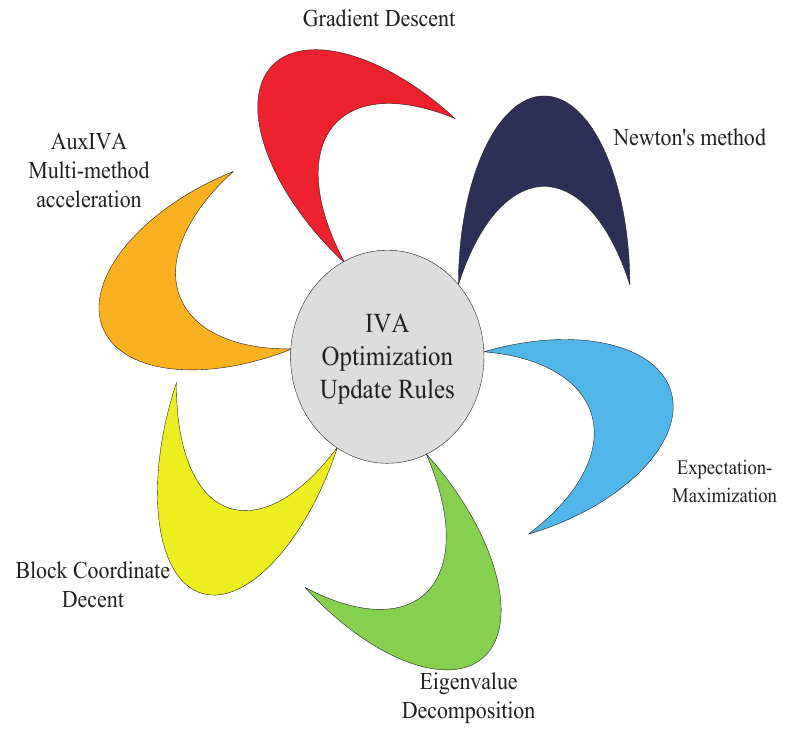
Figure 2. Optimizing update rule